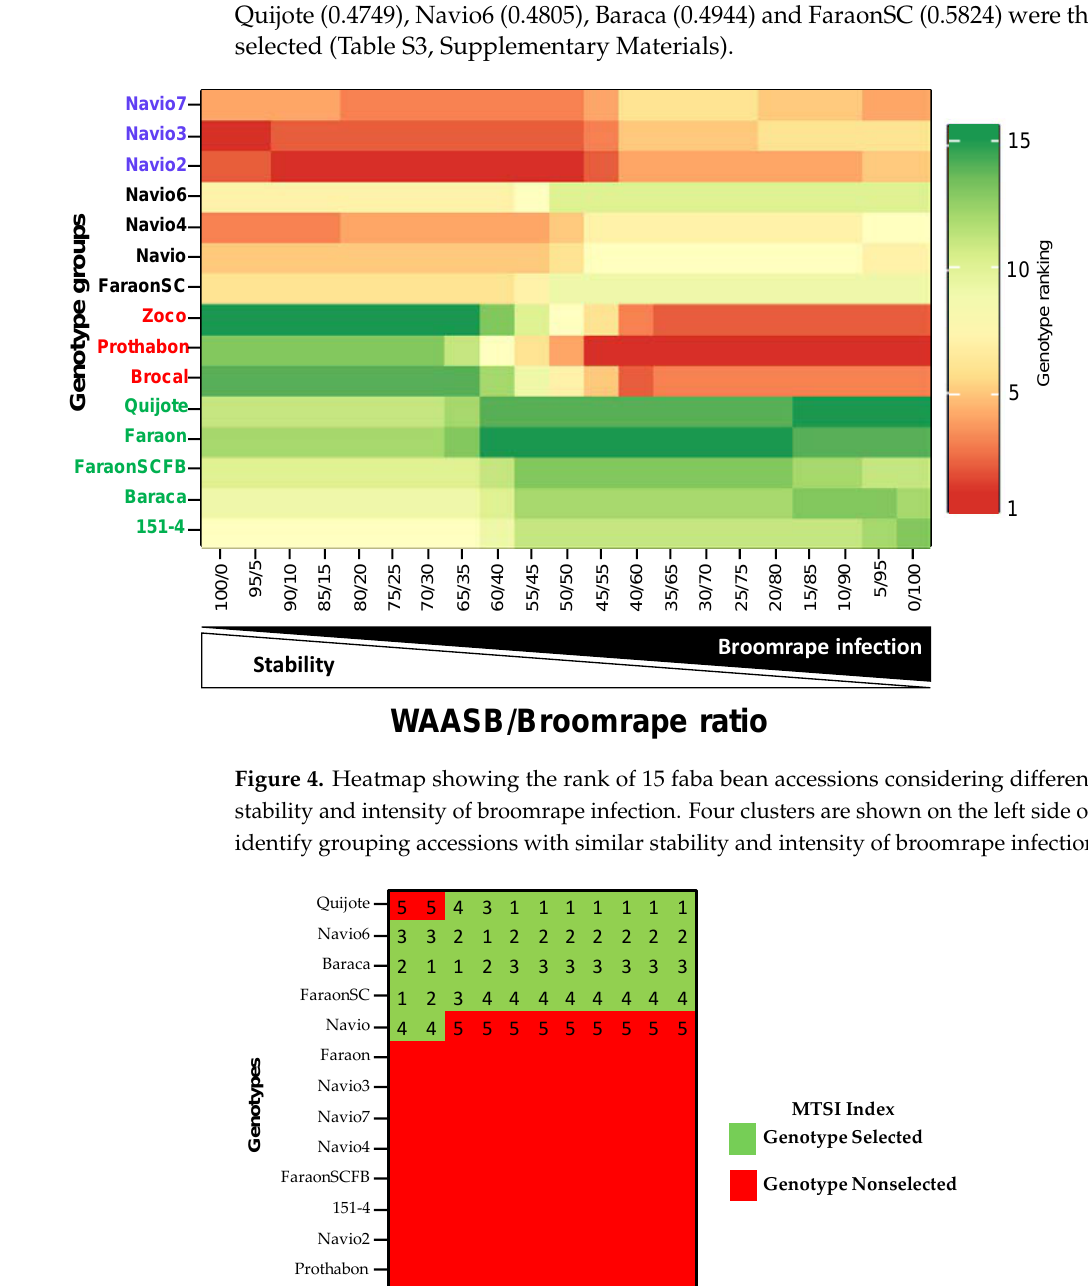
Figure 6. Selected accessions using MTSI for grain yield, and broomrape infection assigning a selec- tion intensity of 25%. The values of WAASBY for each trait were grouped in one factor (FA1) (Table 6 and Table S4, Supplementary Materials). Following the example shown in Figure 6, the selec- tion index of 25% was used to estimate the genetic parameters for grain yield and for broomrape infection (Table 6). For grain yield, the four selected accessions (XS) gave higher values than the original average (XO), which includes all of the accessions. These values were lower for the undesirable trait, broomrape infection. The magnitude of this increment is given by SD. The heritability (92%) and genetic gain (55%) were higher for broomrape infection than for grain yield (79% and 21%) revealing the feasibility of im- proving both of the traits, but with better chances for broomrape infection than for yield. The WAASBY mean (86.71) of the selected accessions was higher than their grand mean (64.73) for grain yield. Conversely, WAASBY mean (23.50) was smaller than its grand mean (37.62) for broomrape infection. The selection differentials for the WAASBY index were 21.98 and −14.12, for grain yield and broomrape infection, respectively. The selection differentials for the WA ASBY indices were 33.95 and −37.52% for grain yield and